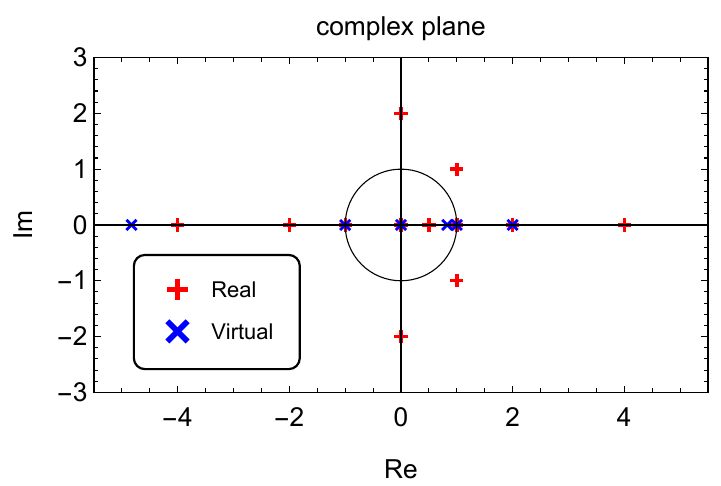
Figure 5 . Singularities of DEs of MIs for both g ! Q (cid:22) Q ( 1 S [1] Plus signs denote singularities encountered in real corrections while multiplication signs denote singularities encountered in virtual